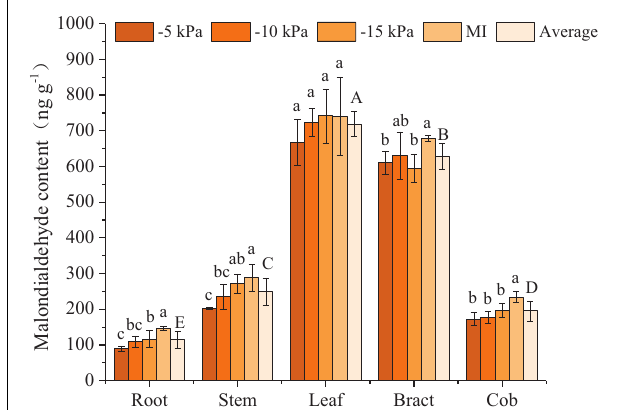
FIGURE 3 | Malondialdehyde content in different organs of maize under different treatments. Values represent mean ± standard deviation. The least significant difference method was used to test differences among treatments or organs at the P < 0.05 level. Different lowercase letters indicate significant differences among treatments within the same organ, and different capital letters on the average value of all treatments in each organ indicate significant differences among organs.